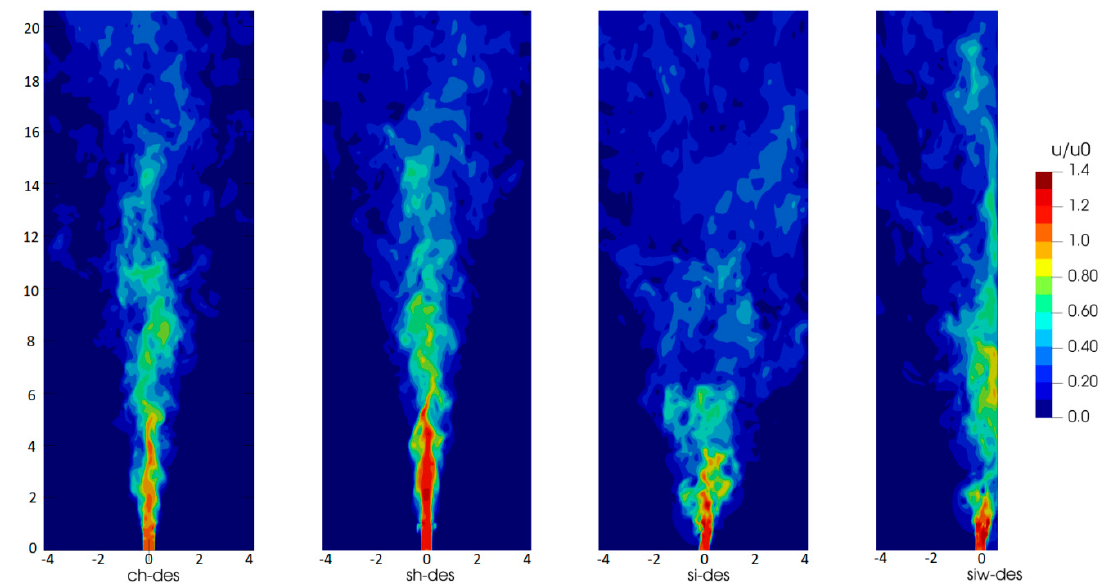
Figure 6. Representative instantaneous velocity fields at z = 0.5 h 0 for all cases simulated with the transient DES model.